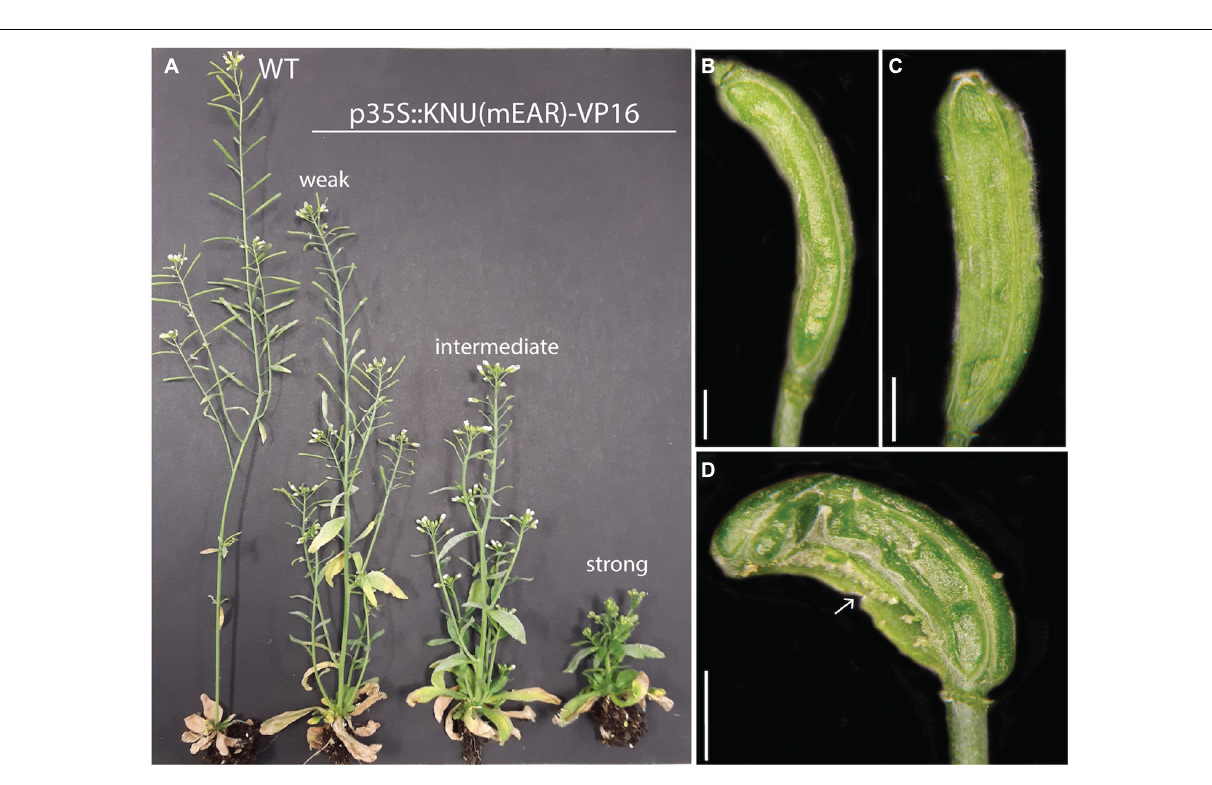
Frontiers in Plant Science |